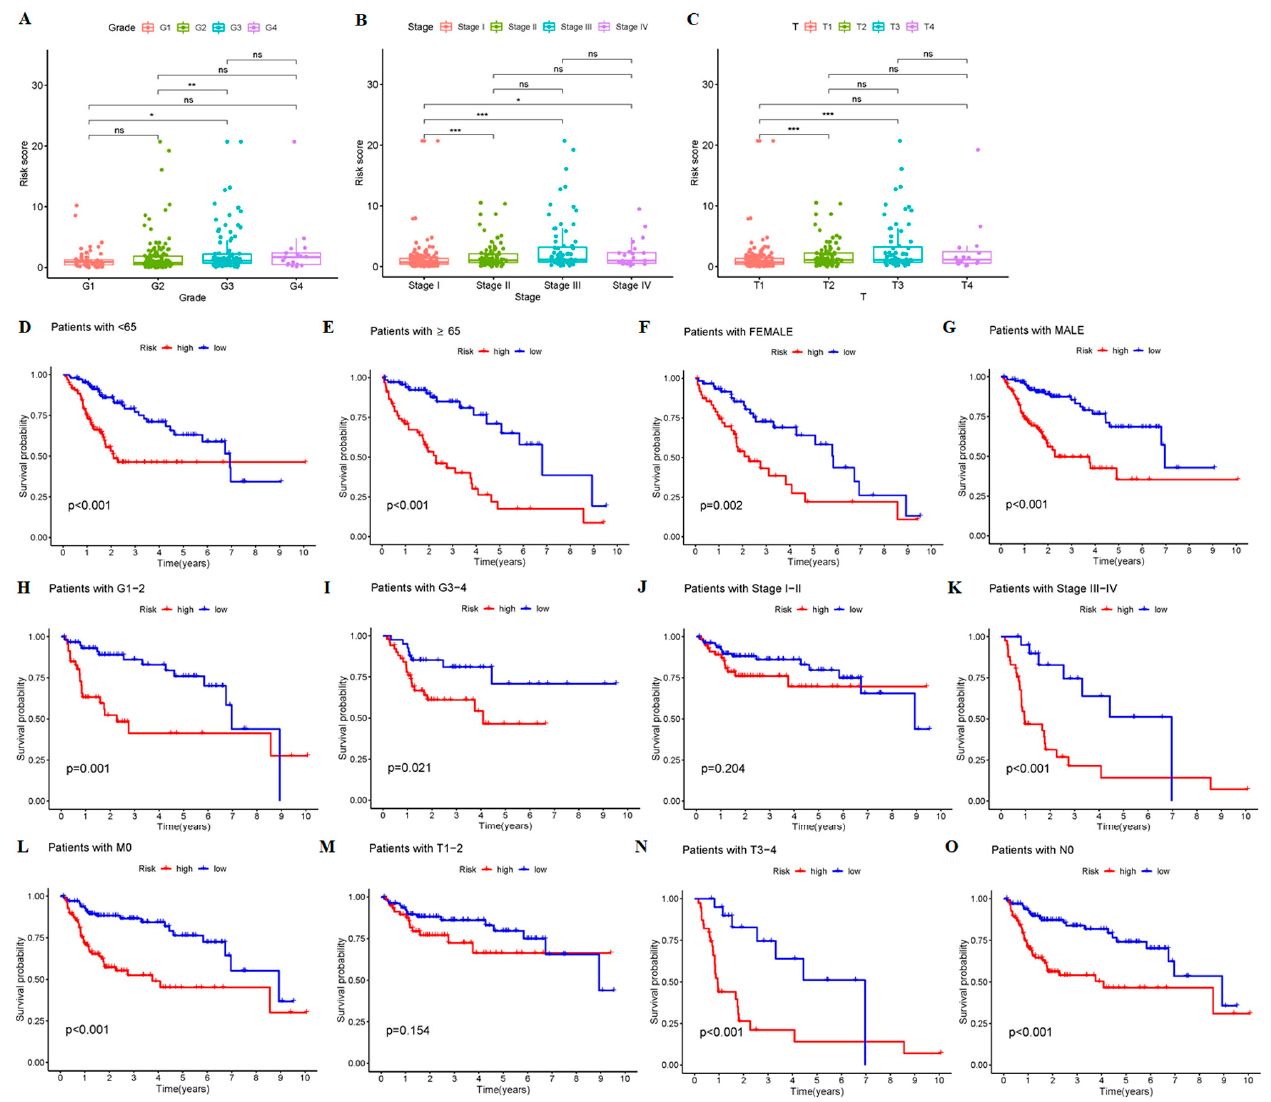
Figure 3. Validation of the 9-crLncRNA prognostic model by clinical characteristics. Based on the median risk score, the entire sample was divided into high-risk group (165 cases) and low-risk group (178 cases). The differences in ( A ) grade, ( B ) stage, and ( C ) T stage were analyzed in HCC patients. * p < 0.05, ** p < 0.01, and *** p < 0.001, and ns means no significance. The K-M plotters of clinical characteristics: ( D ) <65, ( E ) ≥ 65, ( F ) FEMALE, ( G ) MALE, ( H ) G1-G2, ( I ) G3-G4, ( J ) stage I–II, ( K ) stage III–IV, ( L ) M0, ( M ) T1-T2, ( N ) T3-T4, and ( O ) N0. p < 0.05 was considered statistically